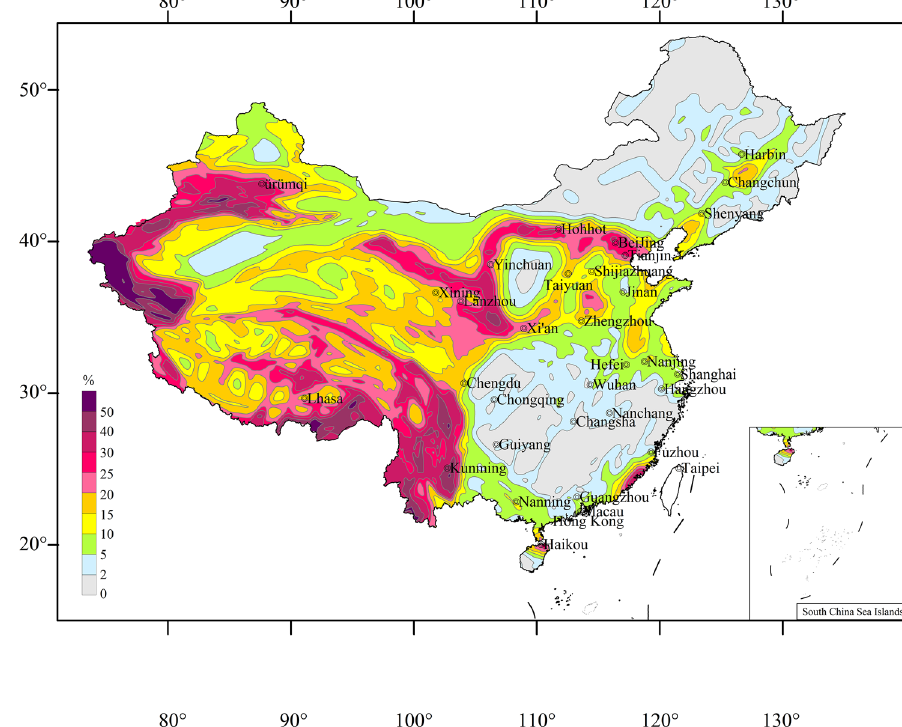
Fig. 10 Spatial distribution of the probability of the modified Mercalli intensity (MMI)